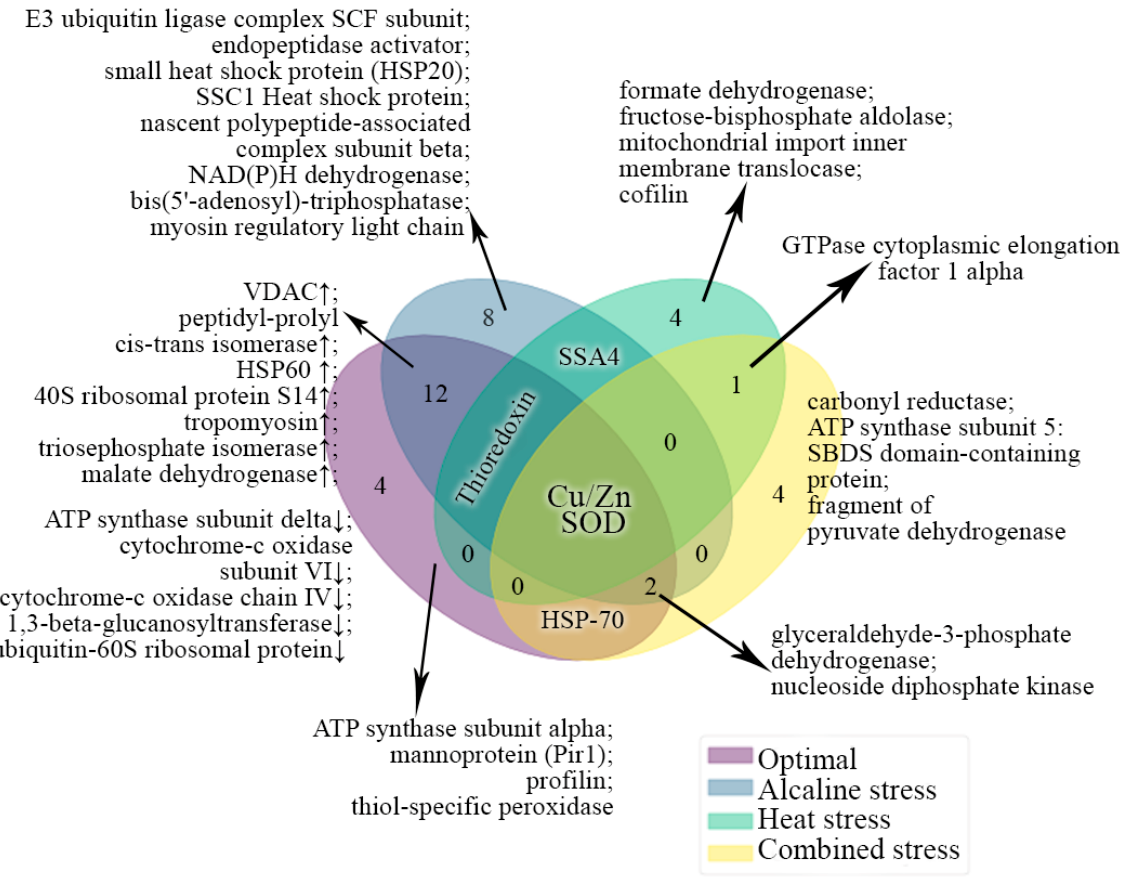
Figure 6. Clustering of differentially expressed proteins according to the frequency of their occurrence under various growth conditions. Different clusters of interacting proteins were identified using the STRING software with the highest conformity score. Different colors indicate the conditions of growth. The number of the common proteins for different conditions are indicated by the